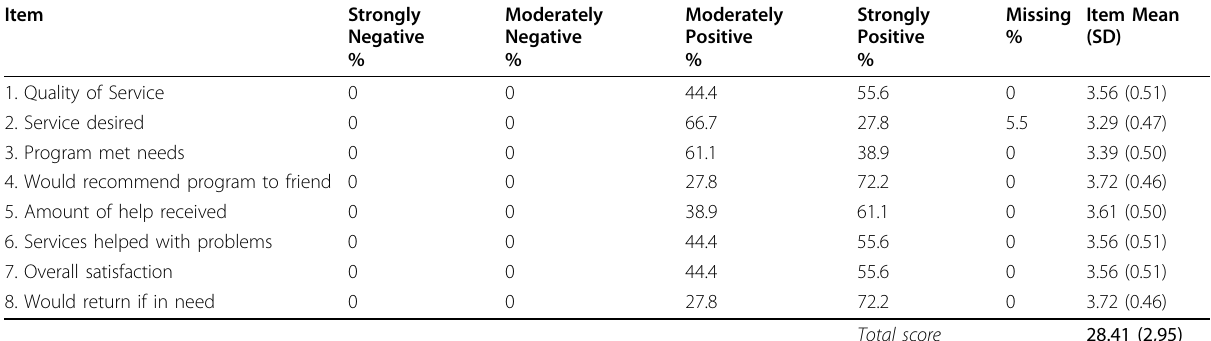
Table 4 Client satisfaction - Distribution of responses (%) and item mean values of each item on the CSQ-8 (N = 18)